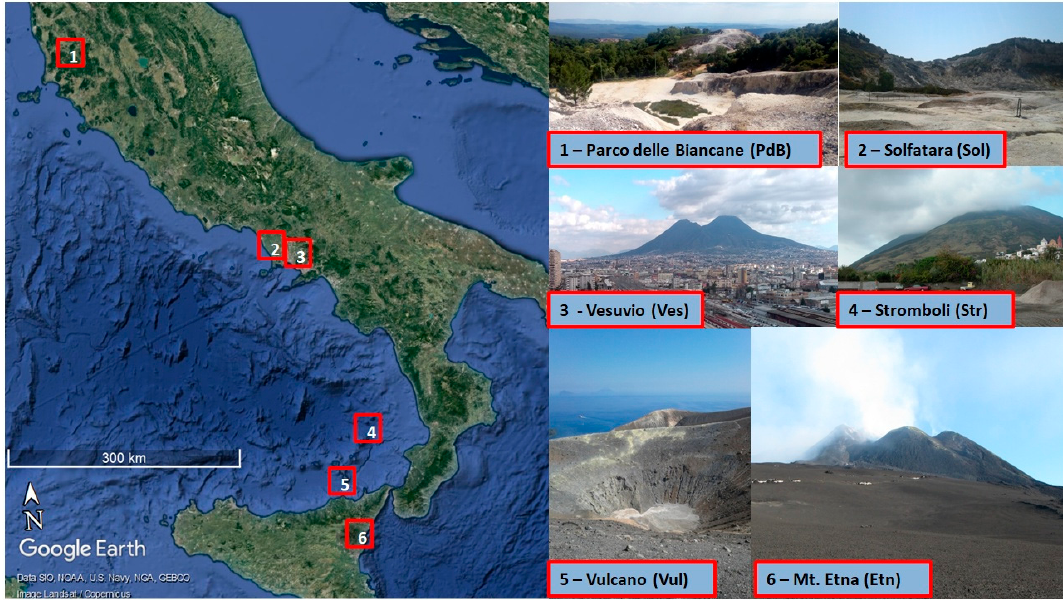
Figure 1. Areas of interest in Italy (Photo credits: Google Earth, M. Silvestri and M. Musacchio). Remote sensing represents an effective and expeditious tool for acquiring infrared images over large areas affected by thermal anomalies. Most Earth-observing satellites pass over an area at the same time of day (Sun-synchronous orbit), measuring targets with the same illumination conditions. Unfortunately, the sensors acquiring data in the TIR range that have frequent revisit time (every day) have a low spatial resolution (1 km or more). Sensors with a longer revisit time (16 days) have